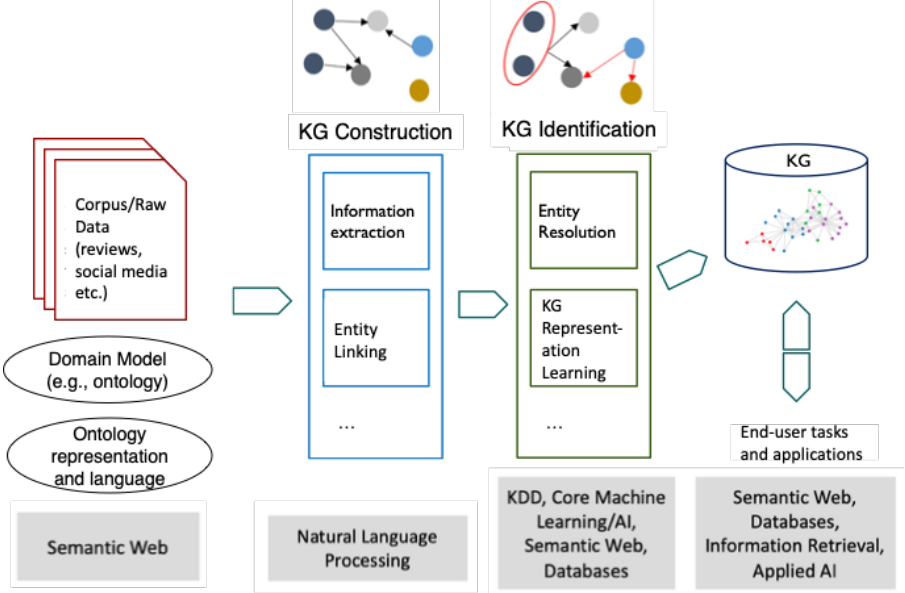
Figure 2. A systems-level overview for unifying KG research areas. Although the ‘flow’ of different areas is represented as a linear workflow, there are complex systems-level dependencies between many of the steps. For example, as discussed in the main text, the choice of KG access and infrastruc- ture (the final step) is strongly influenced by the ontology representation language decided in the first step of the